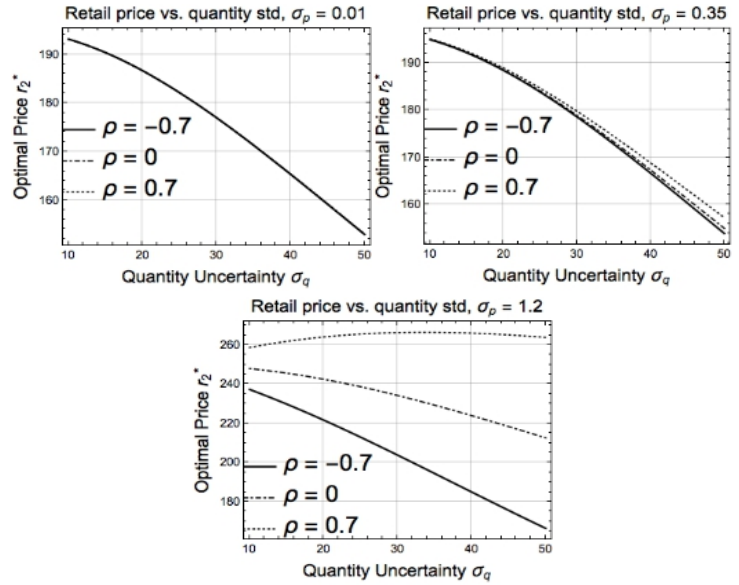
Figure 6. Comparison of r ∗ from Theorem 2 as a function of quantity volatility σ q under small (top-left, σ p = 0.01 ), medium (top-right, σ p = 0.35 ), and large (right, σ p = 1.2 ) price volatility. In each plot, the three correlation conditions ( ρ = −0.7,ρ = 0,ρ = 0.7 ) are also described.